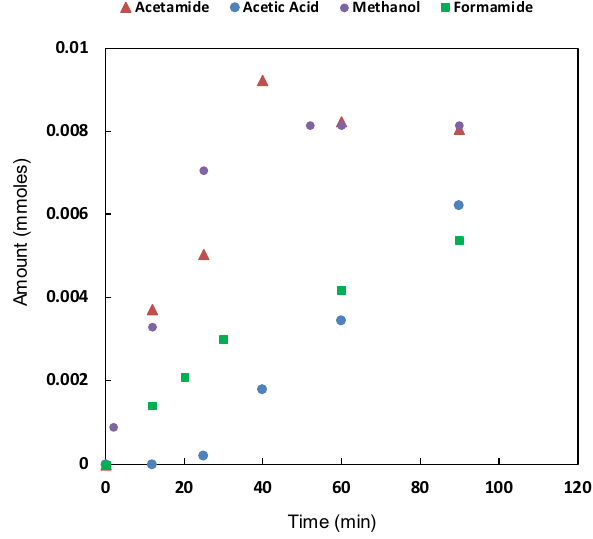
Figure 2. Time dependent acetamide and acetic acid production (Fig. 1) by complex 7-N-Etppz using BF 4 based salt a . Due to low concentration, there is moderate uncertainty in acetic acid quantification. a Reaction